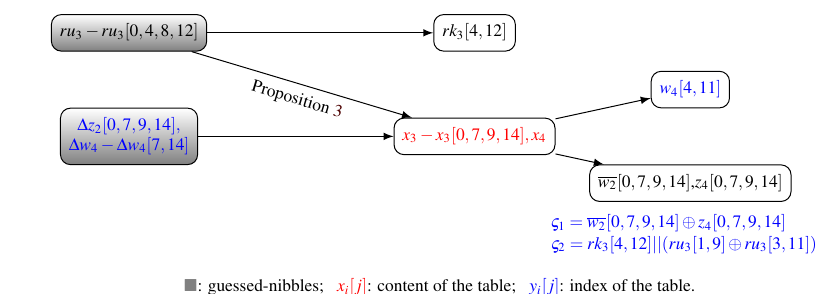
Figure 17: Construction of Table T 1 on the 12-round attack. There are 2 8 values for each index in